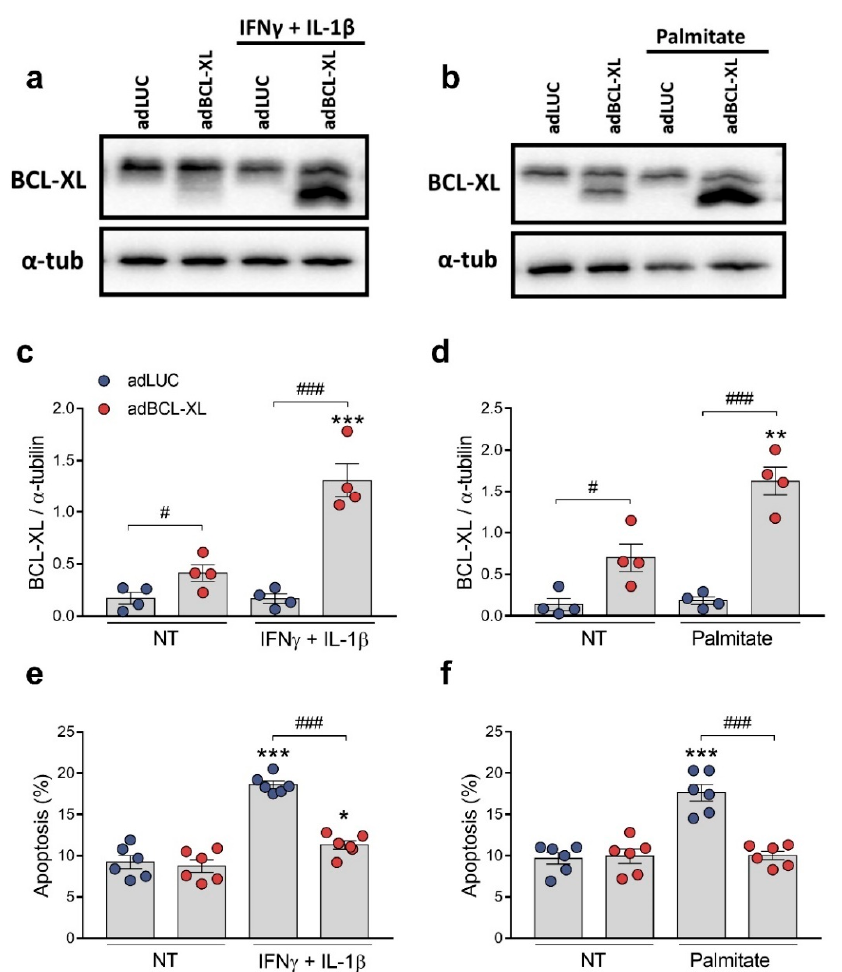
Figure 5. BCL-XL overexpression protects human β -cells from cytokine- and palmitate-induced apoptosis. EndoC- β H1 cells were infected with adenoviral (ad) vectors encoding luciferase (adLUC, blue dots) or rat BCL-XL (adBCL-XL, red dots). After 48 h of recovery, cells were left untreated (NT)